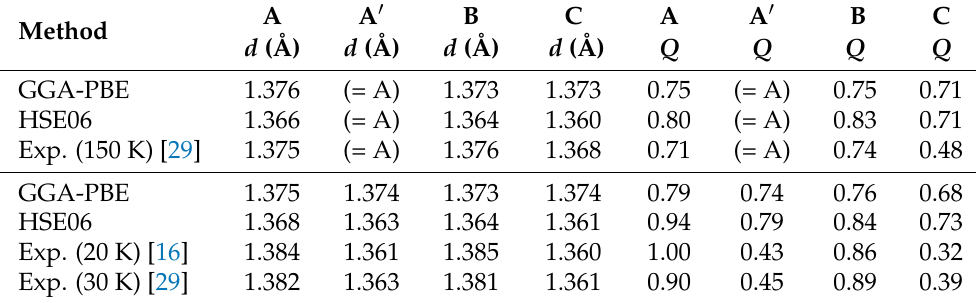
Table 1. Experimental and theoretically-optimized structural parameters for the central C=C double bonds ( d ) and the valence estimated by an empirical method ( Q ) [33] in ET molecules, above (top rows) and below (bottom rows) T CO